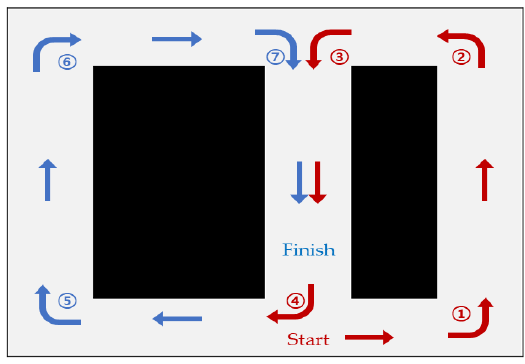
Figure 10. Path in a Driving Track.